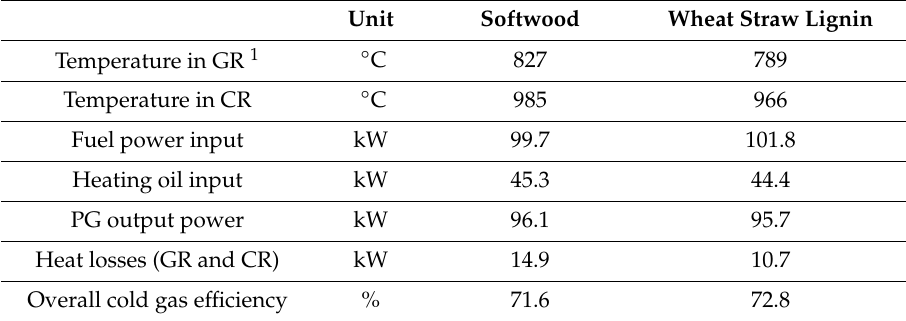
Table 3. Mean temperature in the gasification and combustion reactors (GR and CR), fuel and heating power input, product gas (PG) power output, heat losses of GR and CR and calculated overall cold gas efficiency of the 100 kW DFB gasification pilot plant.